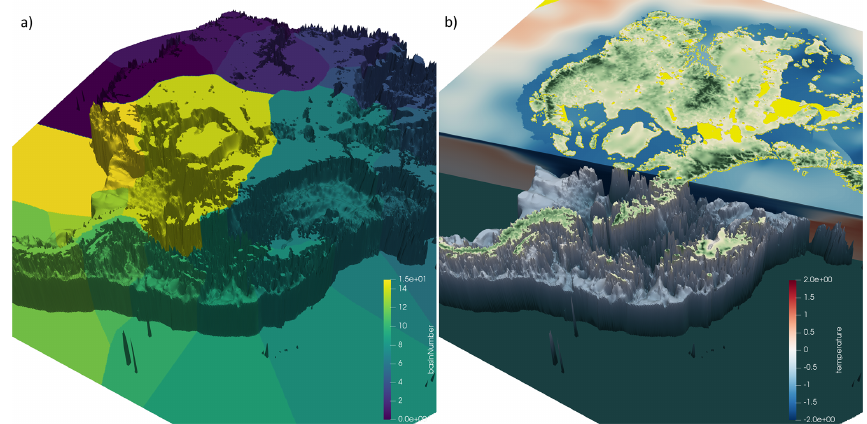
Figure 6. (a) Bathymetry modified from Fretwell et al. (2013) and IMBIE2 basins (Shepherd et al., 2018) used in the sub-ice-shelf extrapo- lation of oceanic conditions. (b) Extrapolated ocean temperature from the observational climatology.